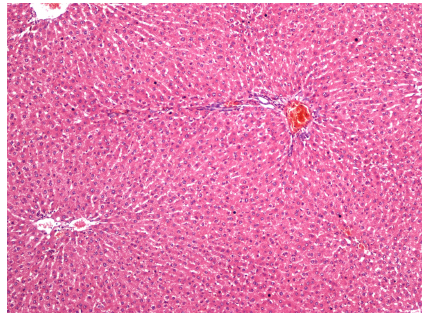
Figure 1. Photomicrograph of liver section of control group showing hepatocytes between the central vein and portal areas. (H&E × 100)